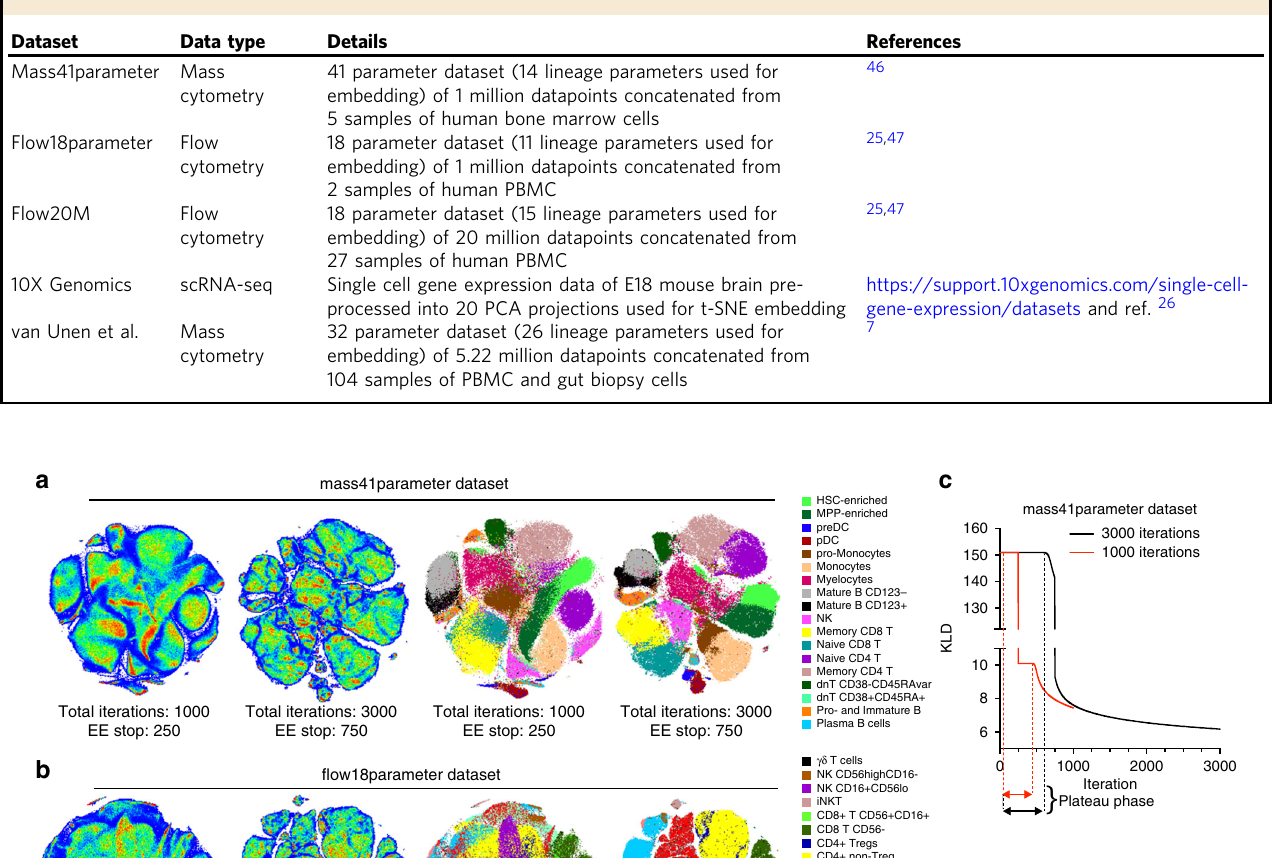
Table 1 Datasets used in this paper